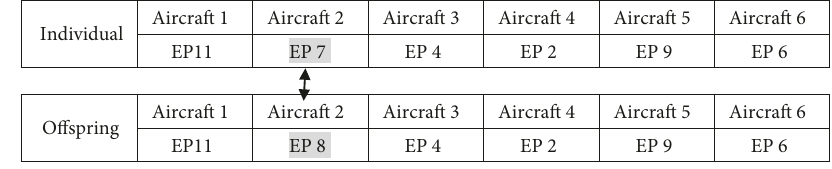
Figure 8: An example of mutation operator. Table 3: Initial solution representation.